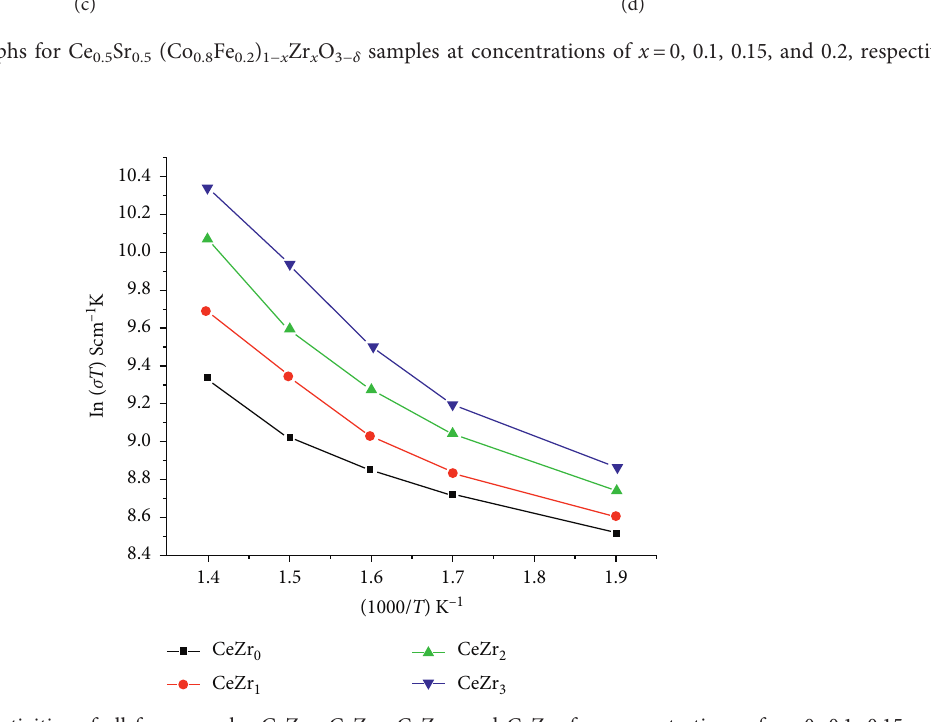
0 , CeZr 1 , CeZr 2 , and CeZr 3 for concentrations of x